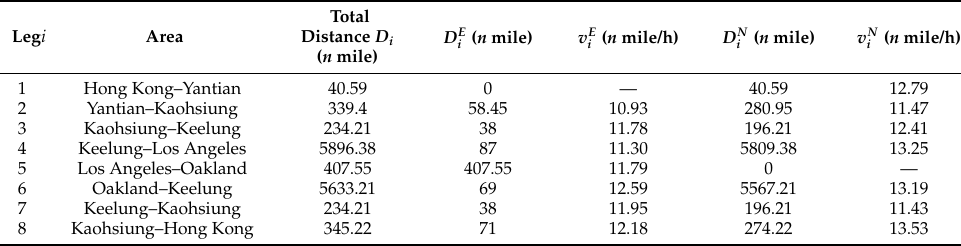
Table 8. Results of minimum sailing cost of speed.